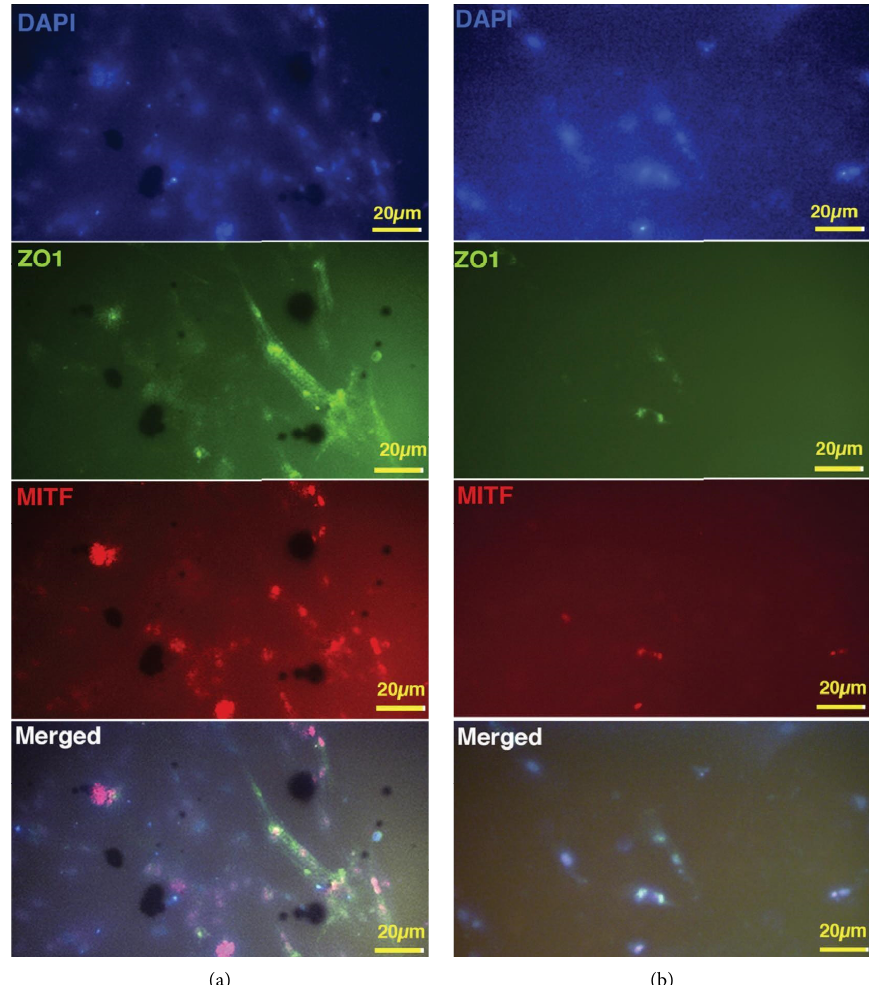
Figure 9: Immunohistochemical staining of the ARPE-19cells grown on the electrospun scafolds for 1-week (a) R-30 and (b) PCL